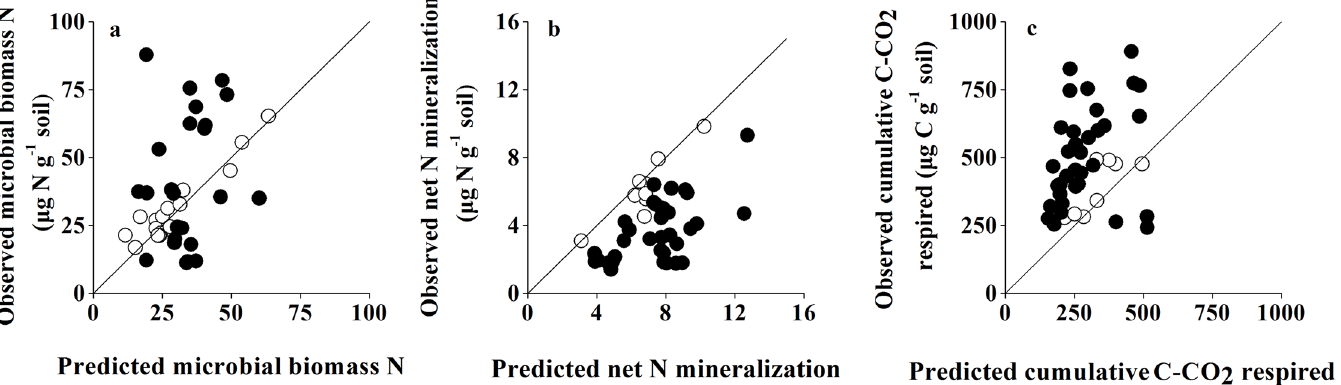
Fig 2. Observed soil microbial biomass N (a), soil net N mineralization (b) and cumulative soil respiration (c) in relation to the expected values calculated from the corresponding monoculture treatments. The line indicatesthe 1:1 relationship along which observed and expectedvalues are equal.Data points represent averages across treatments over time. ● : non-additiveeffects, (cid:14) : additiveeffects.